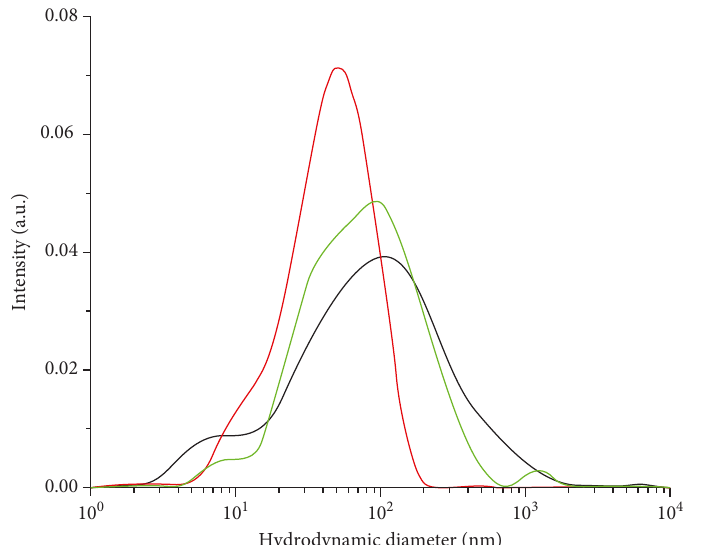
Figure 2: Hydrodynamic diameter distributions for D-g-PNIPAM/AgNP nanosystems at 25 ° С (black curve), 32 ° C (red curve), and 40 ° C (green curve).